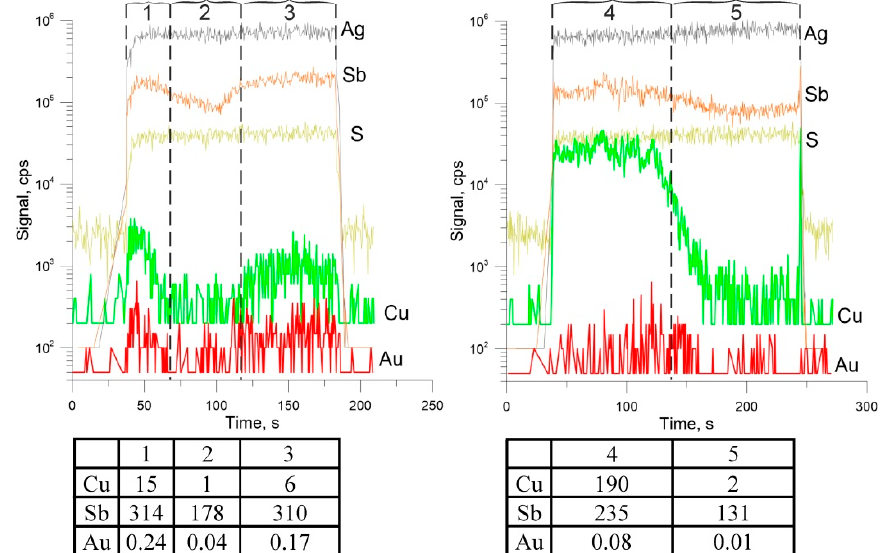
Figure 13. Graphic images of the two probing profiles for the galena crystals from quarts veins of the gumbeites from the Shartash massive, the Berezovsk ore field. Profile length: left—1031 μ m, right—728 μ m.